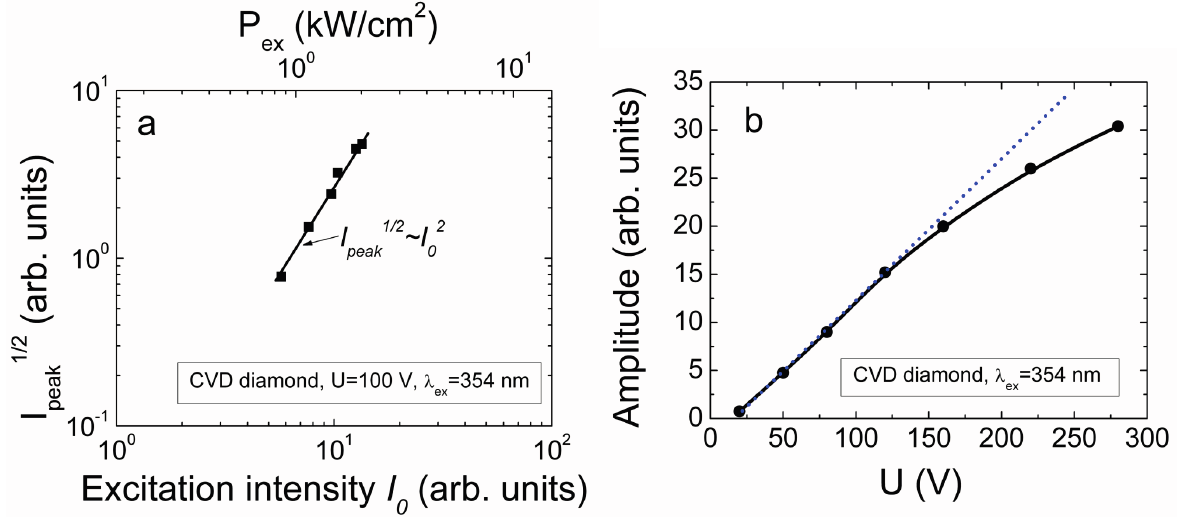
Figure 7. ( a ) The current peak amplitude as a function of excitation intensity at fixed value of applied voltage. The top scale indicates the range of applied power densities; ( b ) The current peak amplitude as a function of applied voltage for the fixed excitation intensity. Both characteristics were measured for CVD diamond by using injection of bulk domain with UV excitation wavelength λ ex = 354